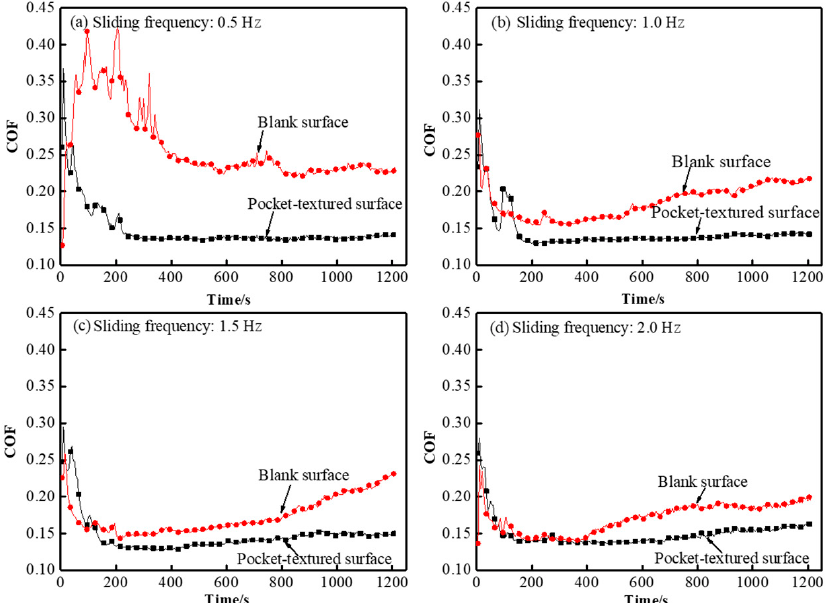
Figure 5. coefficient of friction (COF) comparison of pocket-textured surface and the blank surface under different sliding frequencies of ( a ) 0.5 Hz, ( b ) 1.0 Hz, ( c ) 1.5 Hz and ( d ) 2.0 Hz with a constant load of 2 N.